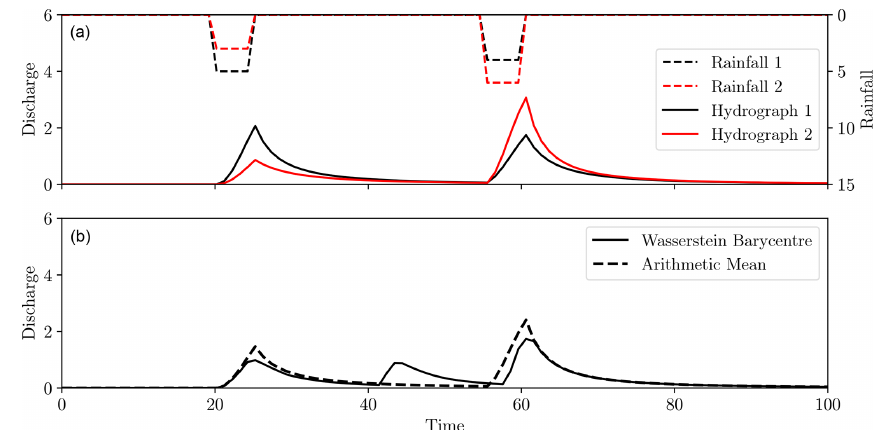
Figure 19. The same hydrological model applied to rainfall events differing in amplitude (dashed black and red, inverted plots in panel a ), giving hydrograph differences purely in amplitude (solid black and red, a ). Panel (b) shows the mean (dashed black) and Wasserstein barycentre